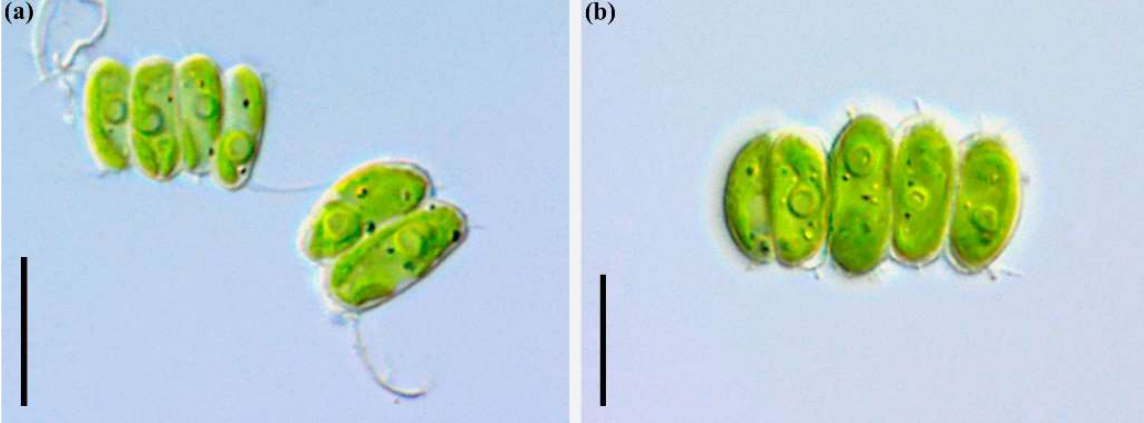
Figure 4. Desmodesmus. armatus (Chodat) Hegewald. Strain ARC06. Coenobia with different number of cells ( a , b ). Scale bars: 10 μm.